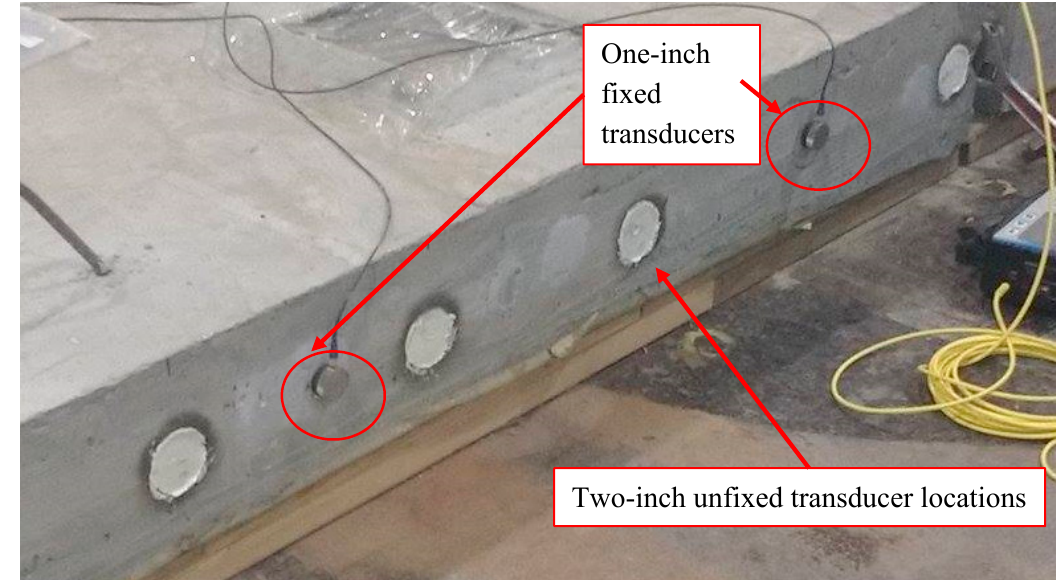
Figure 5. Specimen Set 2 sensor locations.